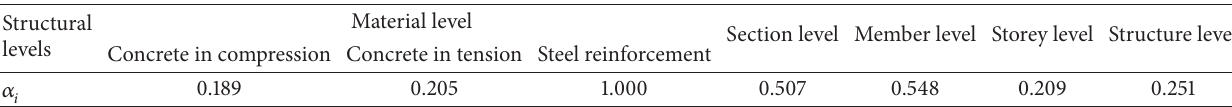
Table 1: Suggested values of 𝛼 𝑖 for each